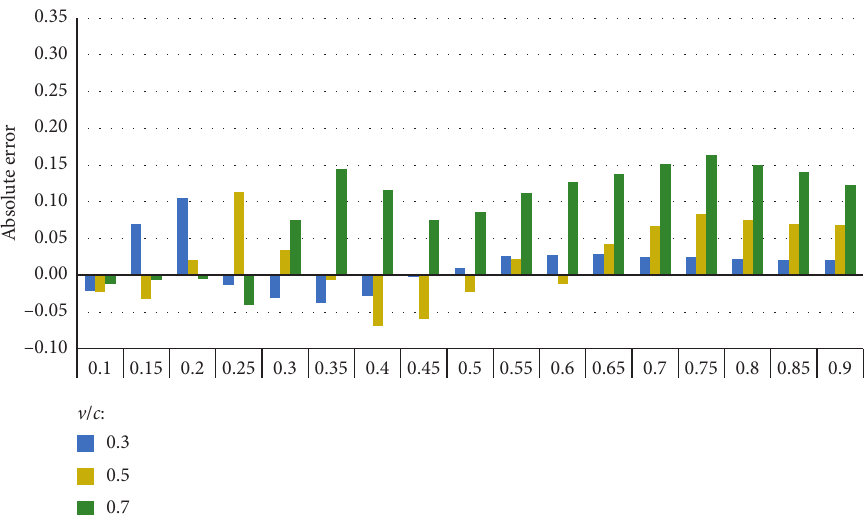
Figure 14: Mathematical deviation between microsimulation calculation and model estimation.